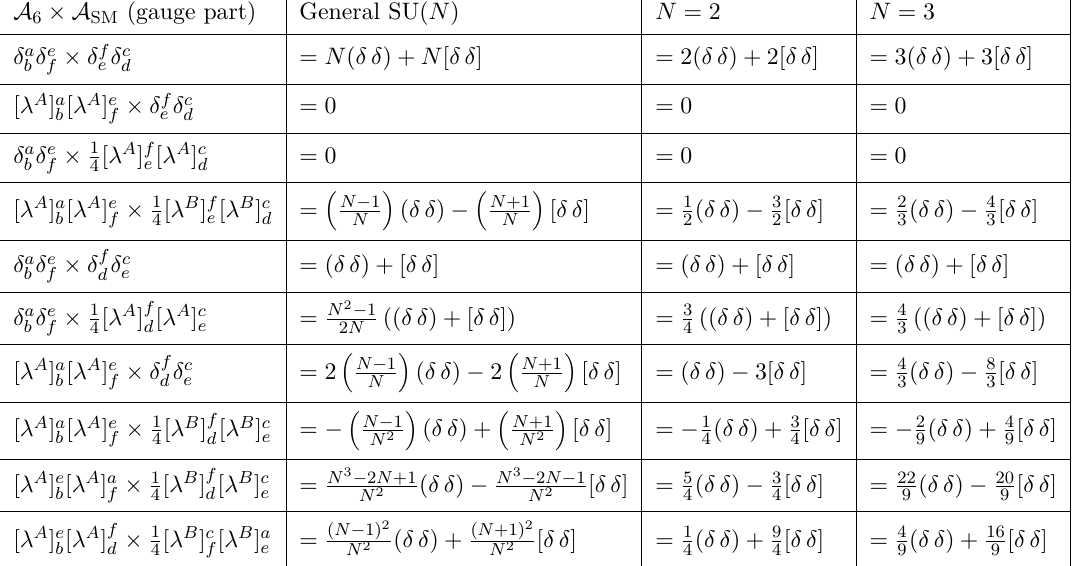
Table 13 . Possible gauge contractions appearing in A 6 × A SM , starting from non-symmetrised structures and expressing the result in terms of (anti)symmetrised structures. The identities are valid for SU( N ) generators λ A normalised such that Tr[ λ A λ B ] = 2 δ AB , and which reduce to the Pauli (Gell-Mann) matrices when N = 2(3) .